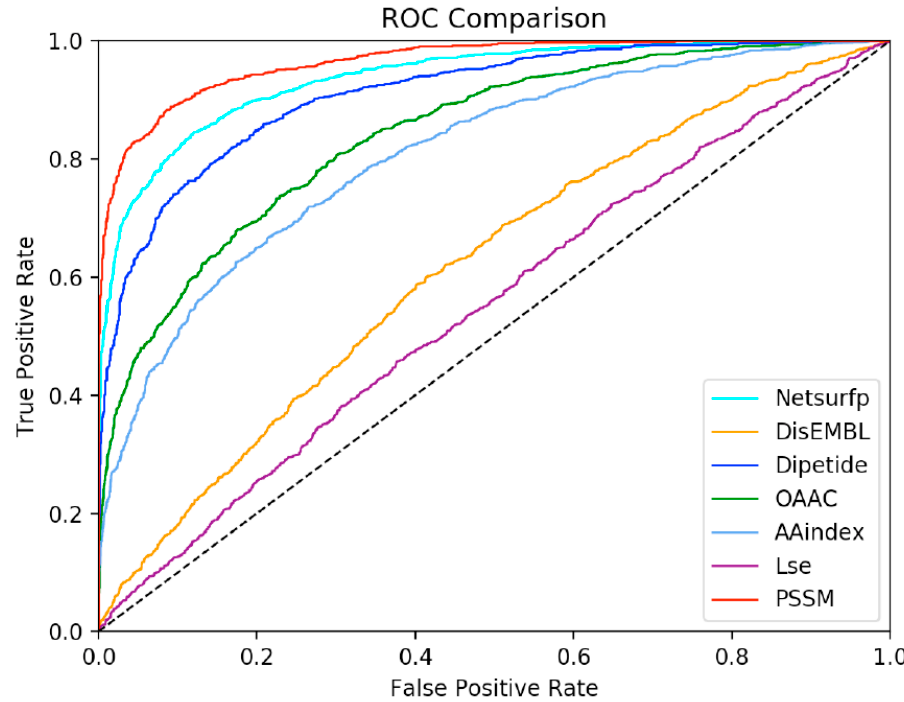
Figure 6. ROC curves of the GTB model on the training set. Different colors represent different types of features.